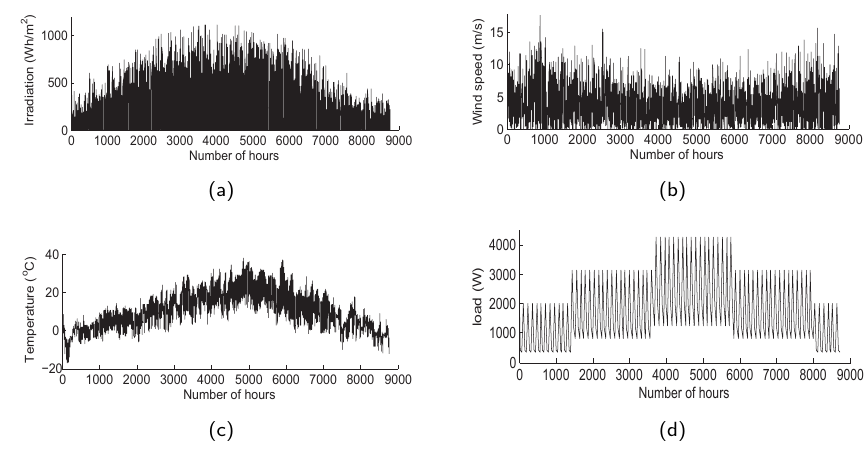
Figure 5. Hourly mean values of meteorological conditions. ( a ) solar irradiation; ( b ) wind velocity; ( c ) temperature; and ( d )